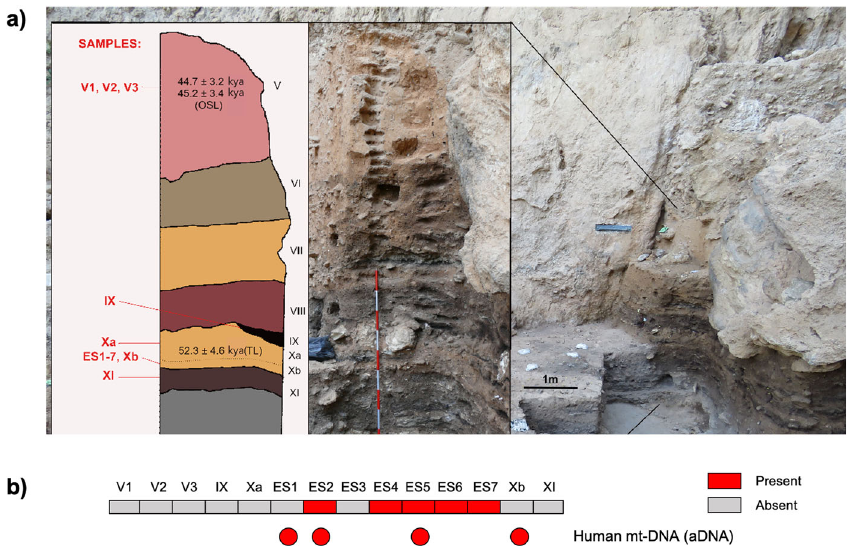
Fig. 2 Pleistocene stratigraphic sequence of El Salt (Units V-XI), chronometric dates of the sampled units, and evidence of traces of ancient human mitochondrial DNA. a The 14 sediment samples included in this study are shown in red. Samples ES1 to ES7 (subunit Xb-H44) are from Sistiaga et al. 25 . b Red boxes, human mtDNA fragments as recovered from metagenomic sequencing data; red circles, con fi rmation of the presence of ancient human mtDNA through target capture and sequencing (please, see Methods for further